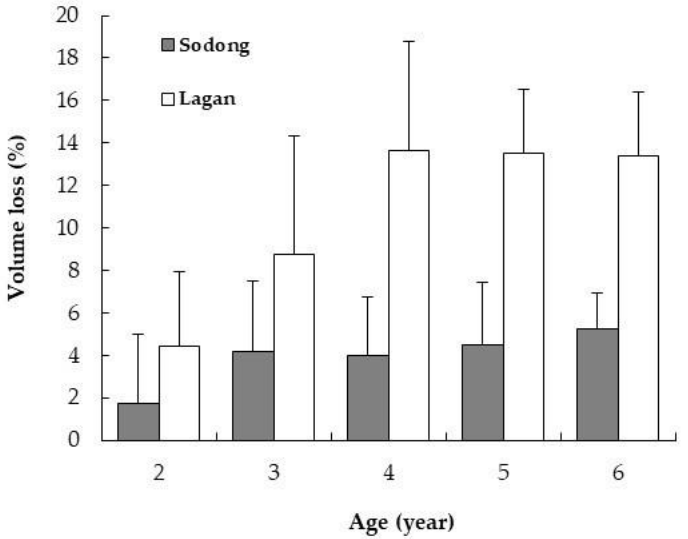
Figure 1. Volume loss of Eucalyptus pellita due to less-intensive weed control (up to age 1 year) compared with more-intensive weed control (up to harvest age) at Sodong (high-productivity site) and Lagan (low-productivity site). Error bars represent SE of means.